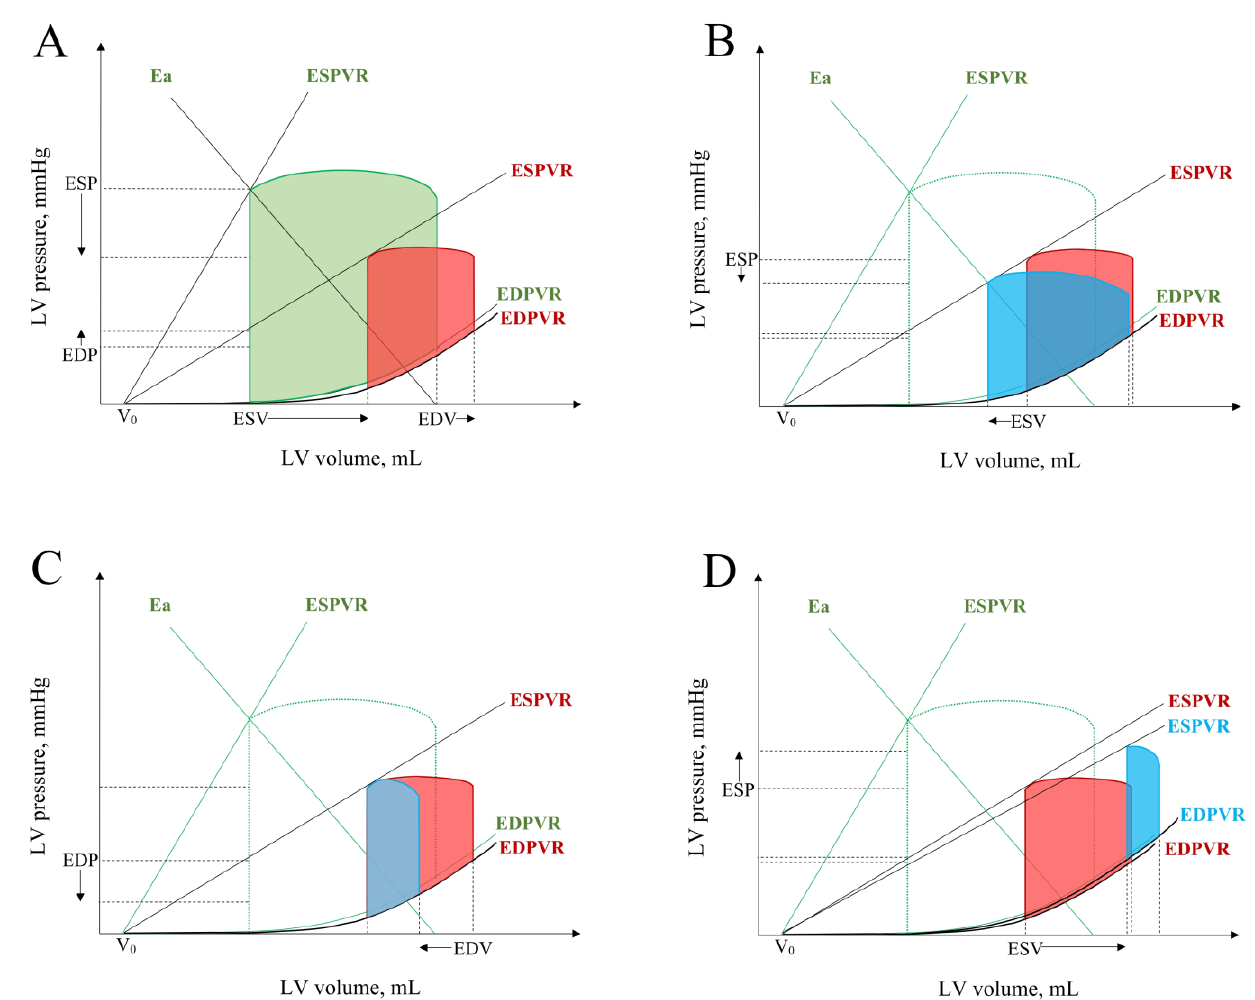
Figure 4. The response of LV pressure–volume loop in cardiogenic shock to short-term mechanical circulatory support. Cardiogenic shock reduces ESPVR slope and diminishes stroke volume ( A ). IABP reduces systolic blood pressure and increases stroke volume ( B ). Impella unloads the left ventricle by reducing its end-diastolic volume and pressure ( C ). ECMO covers peripheral blood demand without unloading of LV end-diastolic function ( D ). Abbreviations: IABP: intra-aortic balloon pump, ECMO: extracorporeal membrane oxygenation, LV: left ventricular, Ea: effective arterial elastance, EDV: end-diastolic volume, ESV: end-systolic volume, EDP: end-diastolic pressure, ESP: end-systolic pressure, ESPVR: end-systolic pressure-volume relationship, EDPVR: end-diastolic pressure-volume relationship. Green LV pressure–volume loop is for physiological conditions, red for cardiogenic shock, and blue for various types of short-term MCS.